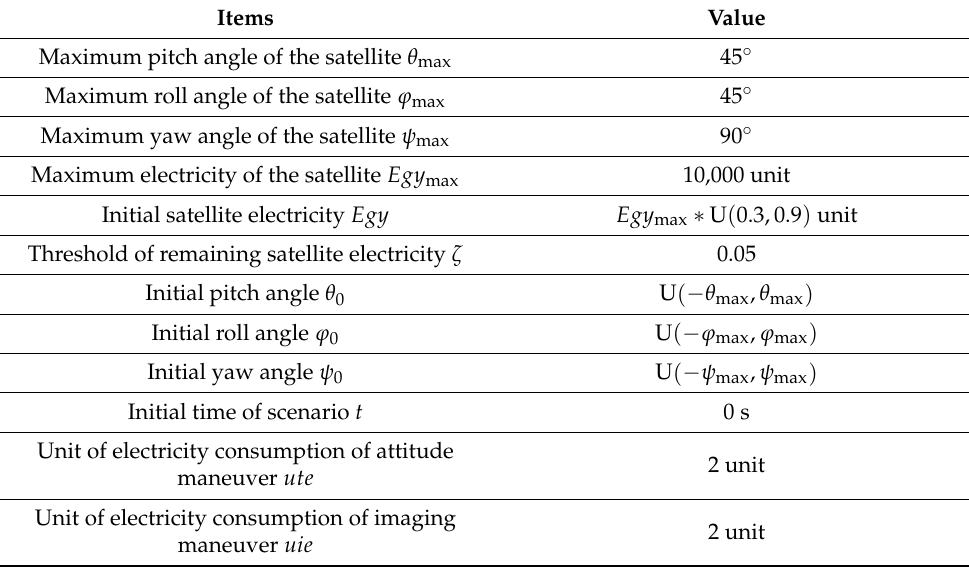
Table 5. The parameter distribution of the satellite